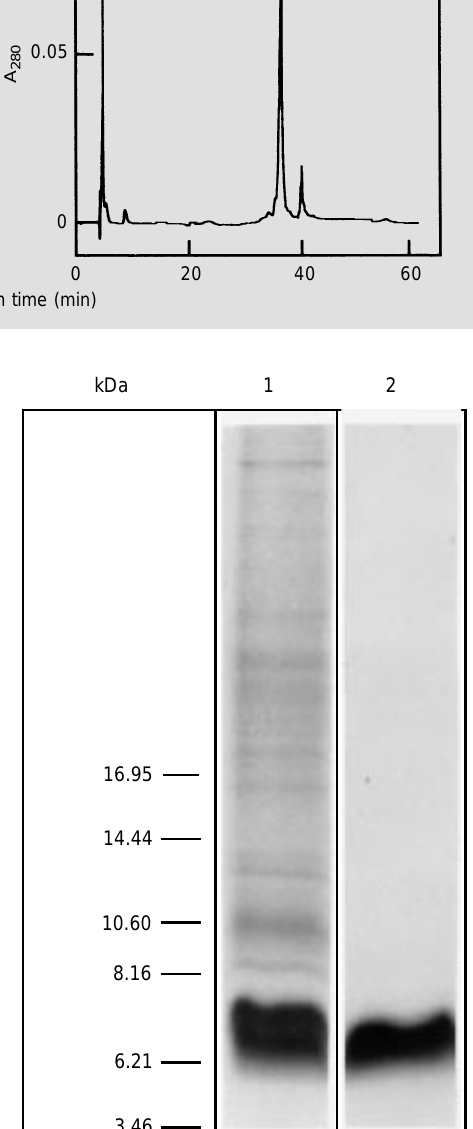
Figure 2 - A, Chromatography of a fraction enriched with the 6.5- kDa protein on a Superdex Pep- tide HR 10/30 column. Proteins (1.0 mg in running buffer) were eluted with 50 mM ammonium bicarbonate at a flow rate of 0.5 ml/min and samples of 1.0 ml were collected. The fractions in- dicated by the horizontal bar were pooled and subjected to the next purification step. B, RP- HPLC of the fraction enriched with the 6.5-kDa protein on a µ- Bondapak C-18 column. Proteins (200 µg) were eluted with a lin- ear gradient of 0-60% acetoni- trile in 0.1% trifluoracetic acid run for 60 min.